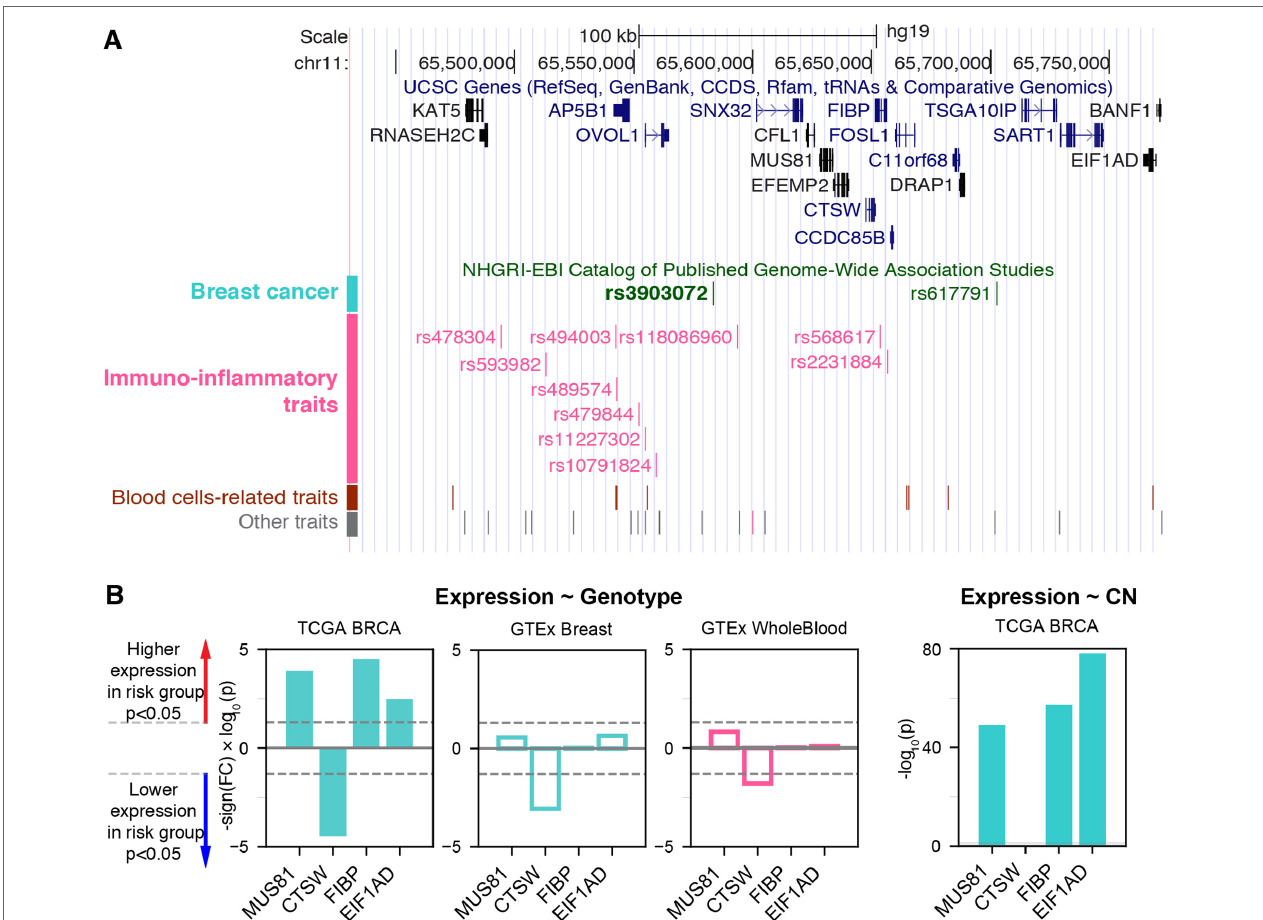
FIGURE 1 | The breast cancer risk variant rs3903072 in the 11q13.1 region. (A) The top track shows UCSC genes, and the lower track shows the GWAS variants grouped by their reported traits into four categories ( Supplementary Table 1 ). The SNP rs3903072 shows a stronger association with breast cancer ( p = 2 × 10 –12 ) than the variant rs617791 ( p = 7 × 10 –6 ). (B) The eQTL results for rs3903072. A full list of eQTL genes is in Supplementary Table 3 . Left three bar plots show the significance of the contribution from rs3903072 genotype to the expression level of MUS81, CTSW, FIBP and EIF1AD . Positive values represent higher expression as the number of risk allele increases, and negative values represent the opposite trend. CTSW is the only eQTL gene with a significant suppression in the risk genotype group. This negative correlation between CTSW expression level and the genotype status is confirmed in the three independent datasets shown. The right bar plot shows the significance of the contribution from gene copy number to the expression level of each gene. Filled bar plots represent tumor, while transparent plots represent normal tissues; in this paper, we use the cyan color to indicate breast-related cancer or normal cells and the magenta color to indicate blood-related cells. The dotted lines in gray mark the significance threshold of p =